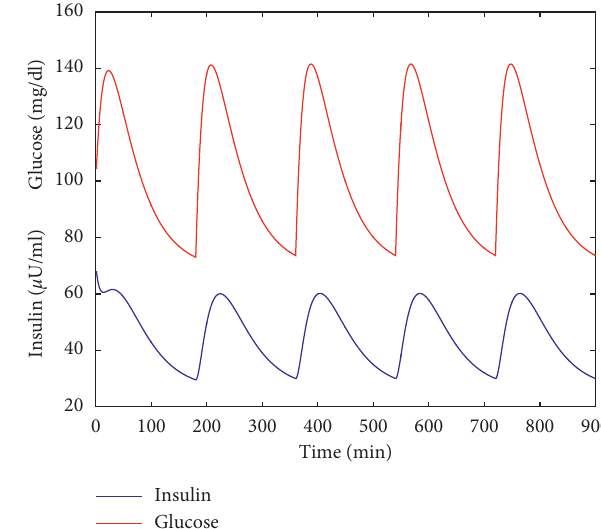
Figure 4: Changes of glucose and insulin levels of system (5).